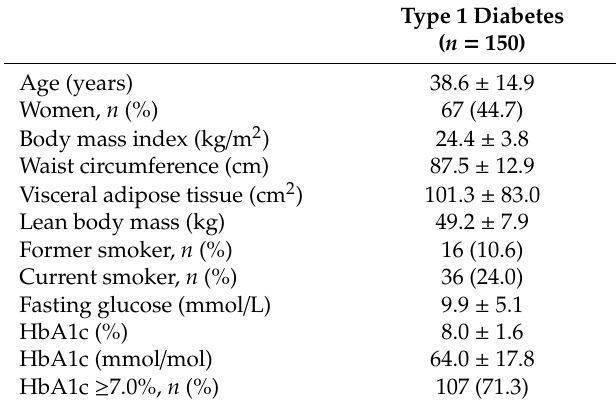
Table 2. Main clinical and metabolic characteristics of the entire population with type 1 diabetes in which the influence of insulin therapy on lung function was